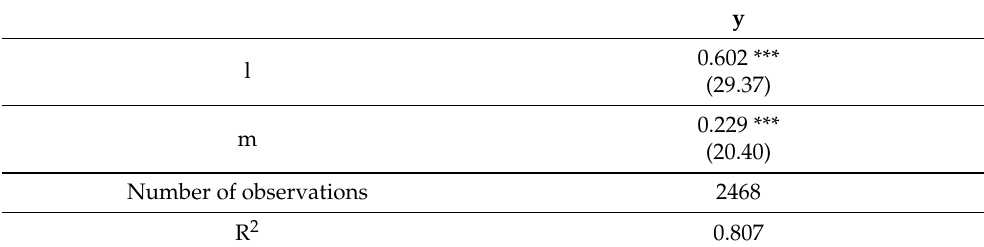
Table A1. First stage TFP estimation—OP